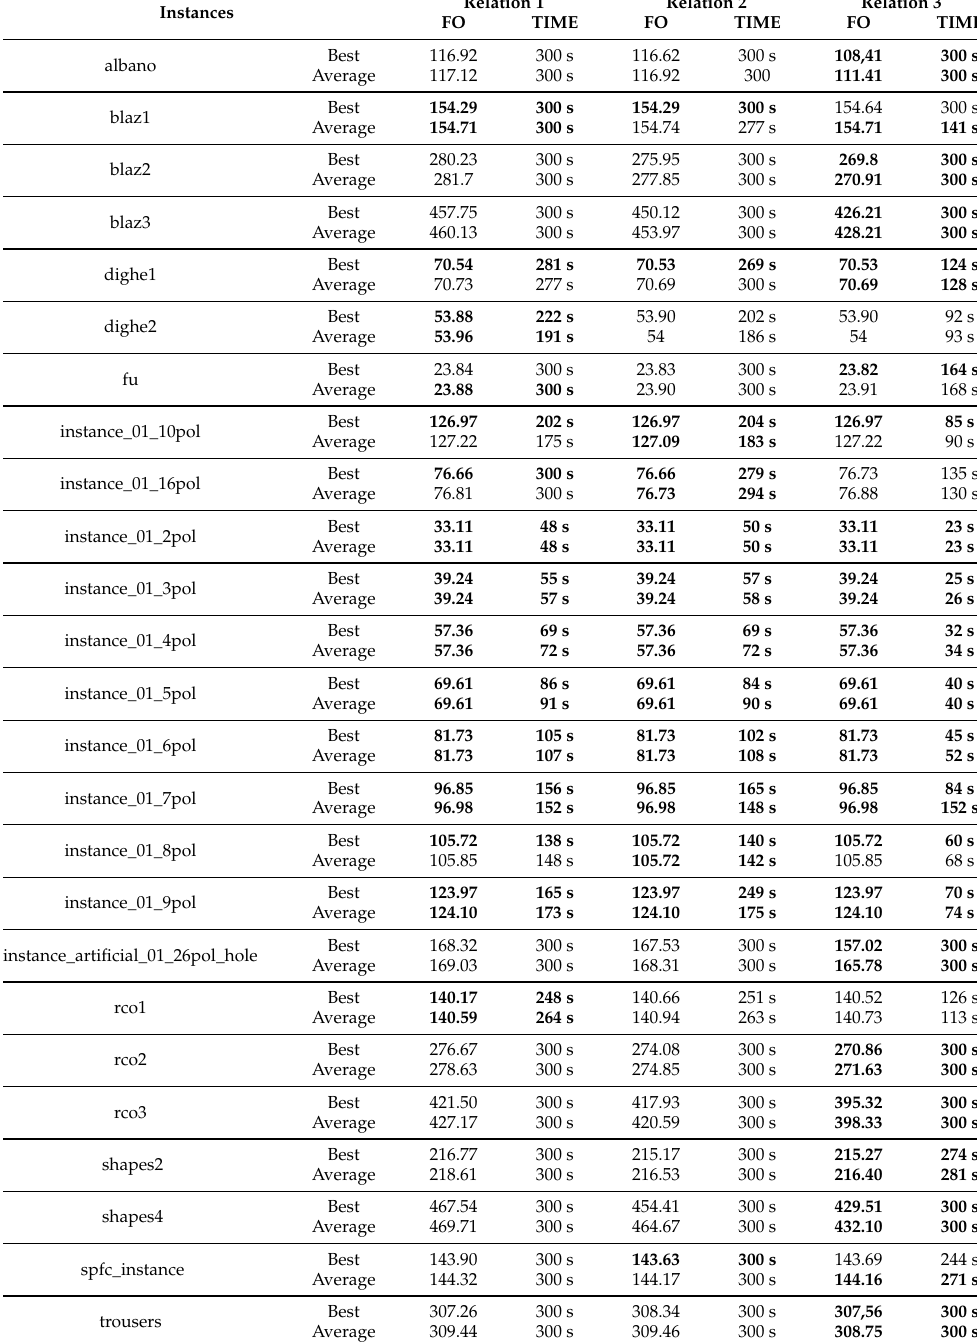
Table A3. Connected instances (C) for considered configurations. Relation 1: P = 10,000; Pe =